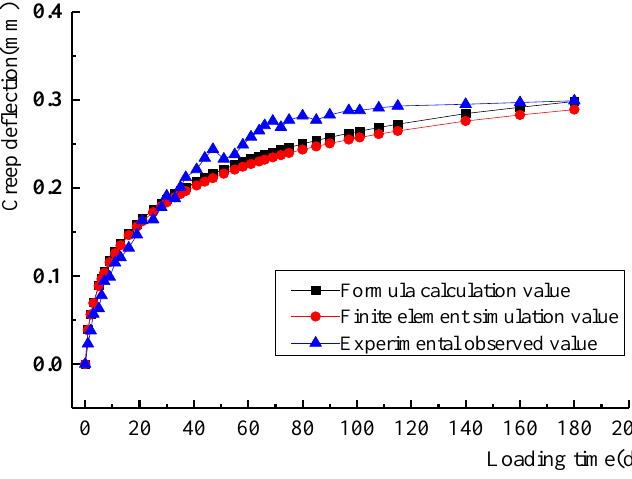
Figure 9. Creep-time curve of specimen TBB4.